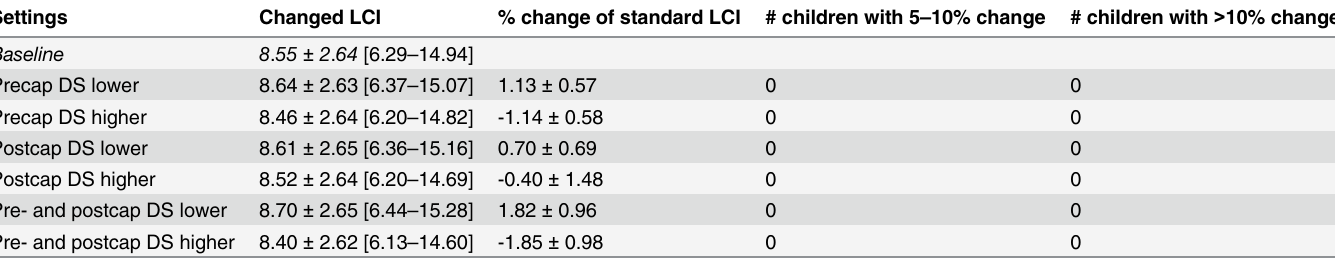
Table 5. Effect size of the change in LCI after reanalysis with different apparatus dead space. Settings